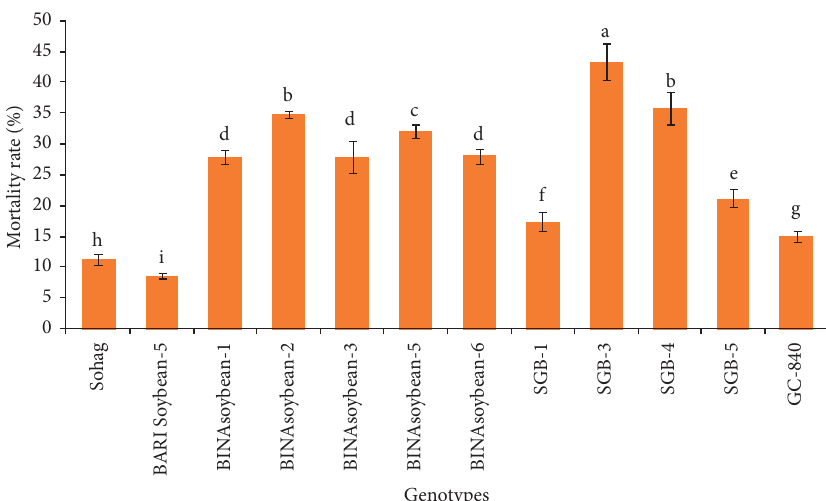
Figure 1: Effect of waterlogging stress on the mortality rate of different soybean genotypes at 12days after treatment. For each treatment, the mean ( ± SD) was determined from three replicates. Different alphabets on the bars indicate significant difference at P ≤ 0 . 05 after mean comparison by Fisher’s LSD